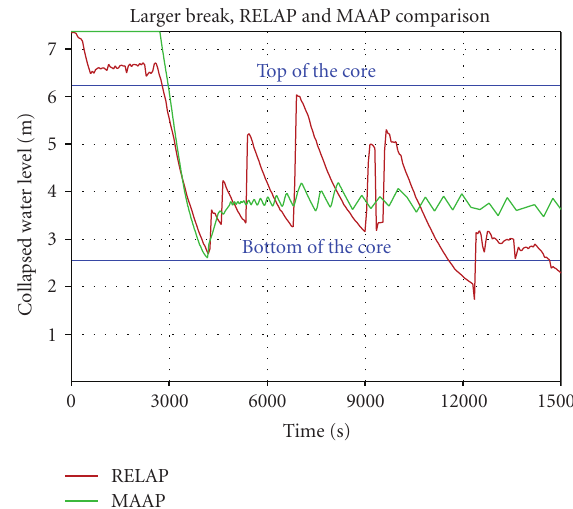
Figure 16: Collapsed water level in the reactor vessel, Group